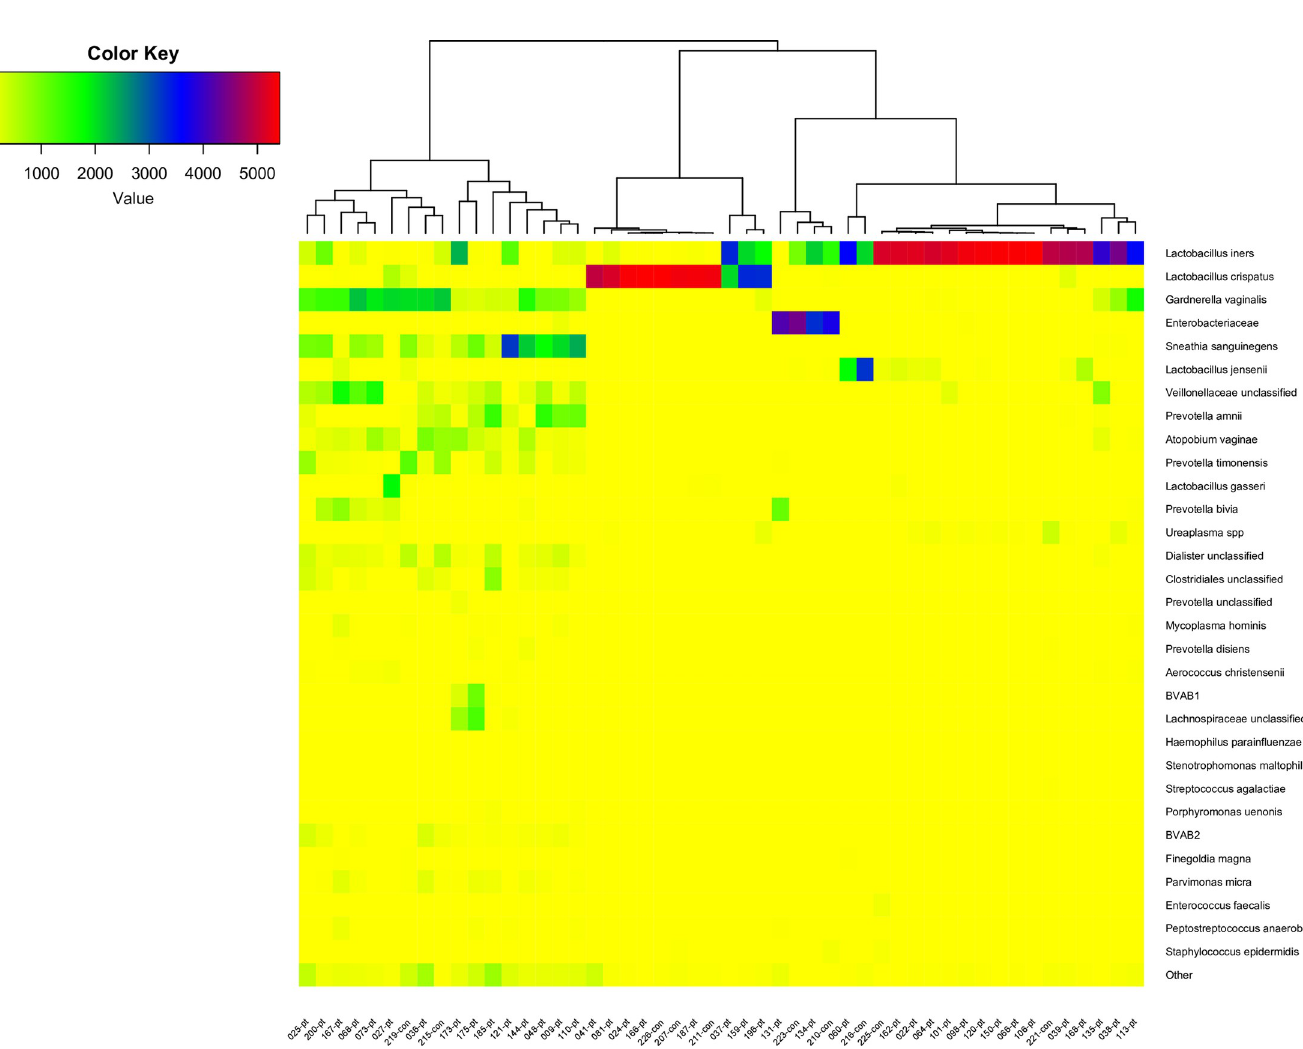
Fig 2. Heatmap of 31 dominant OTUs and the rest combined as “other” of sample 0 from the patients and sample 1 from the controls. The dendrogram show a hierarchical clustering of samples based on Bray-Curtis dissimilarity. The patient number and group (con = control, pt = patient) is shown on the